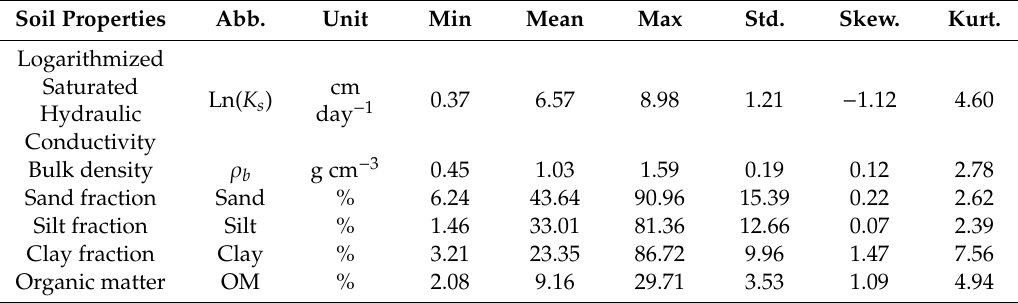
Table 1. Descriptive statistics for forest soil properties.